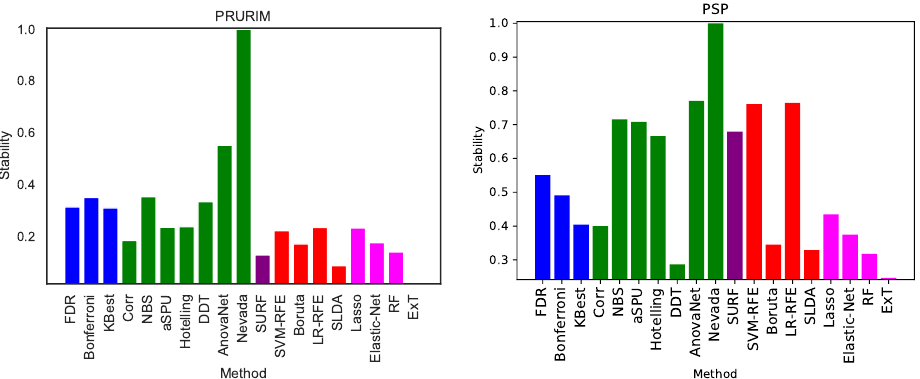
Figure 9. Best classification scores, in terms of the F1 metric, for the PRURIM ( left panel ) and PSP ( right panel ) datasets.